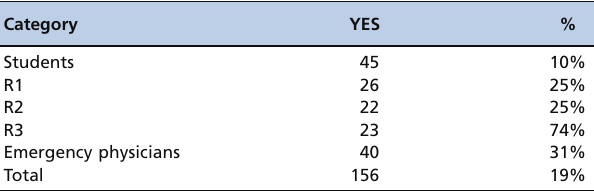
Table 3 - Percentage of physicians who considered themselves able to set the VCV mode.